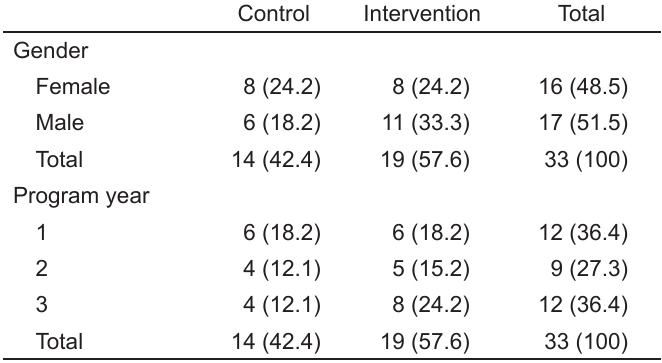
Table 1. Counts and percentages of 33 emergency medicine resident participants in emotional intelligence training by gender and program year.